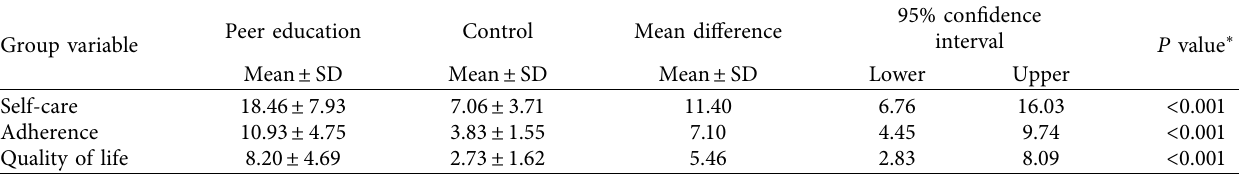
Table 3: Comparison of the mean differences of self-care, adherence, and quality of life scores before and after the intervention. Group